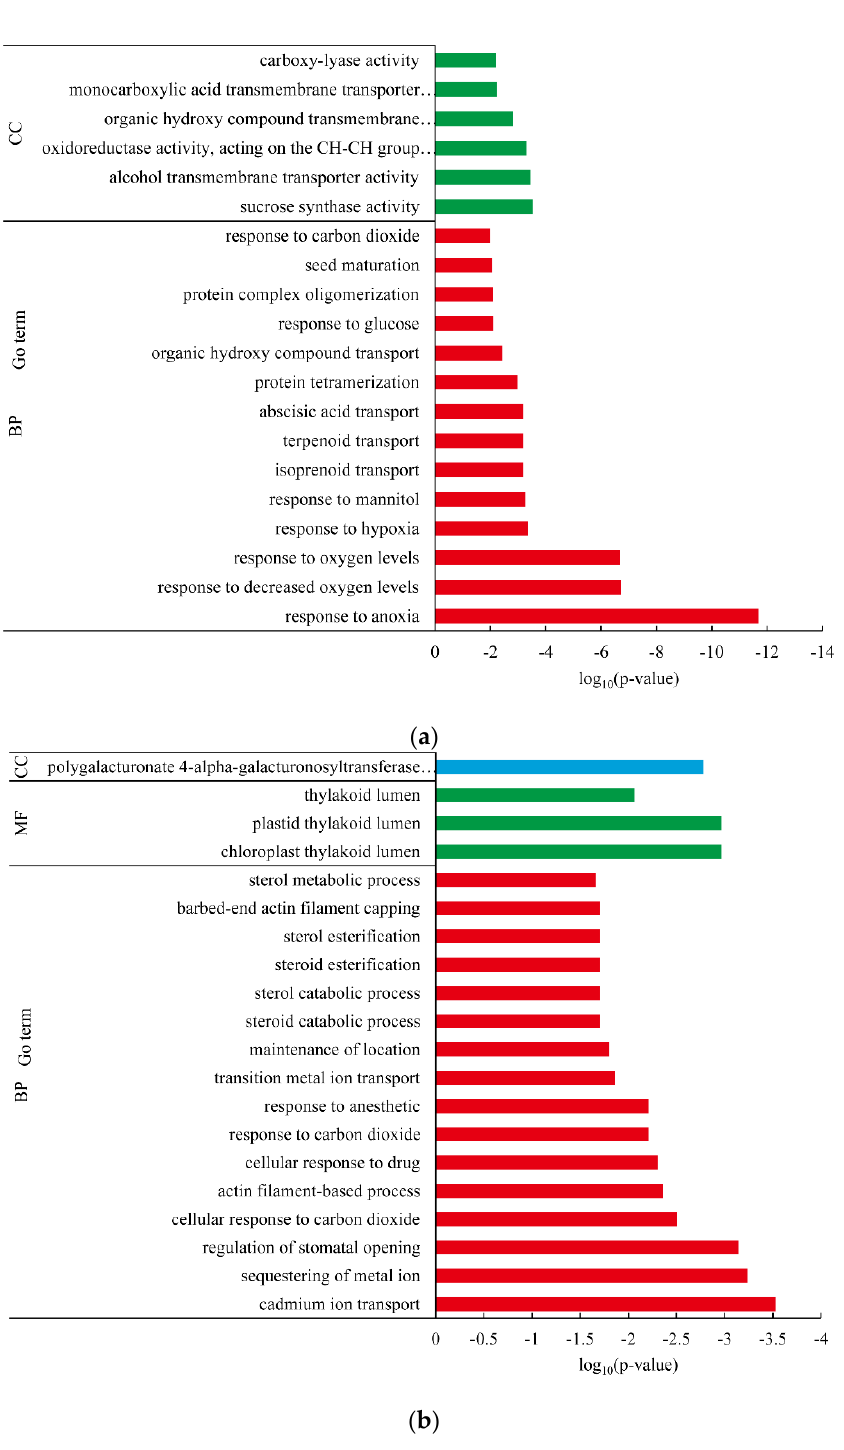
Figure 6. GO enrichment of DEGs in the root of WH3 vs. BH. ( a ) upregulated genes; ( b ) downregulated genes. GO terms belonging to biological processes (BP), cellular components (CC), and molec-ular functions (MF).